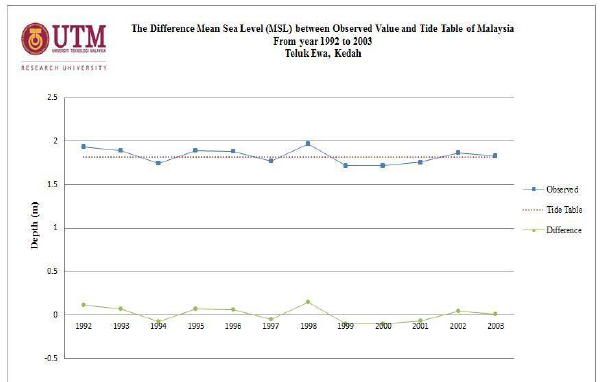
Figure 18. Graph of Difference Mean Sea Level (MSL) between Observed Value and Tide Table of Malaysia at Teluk Ewa,